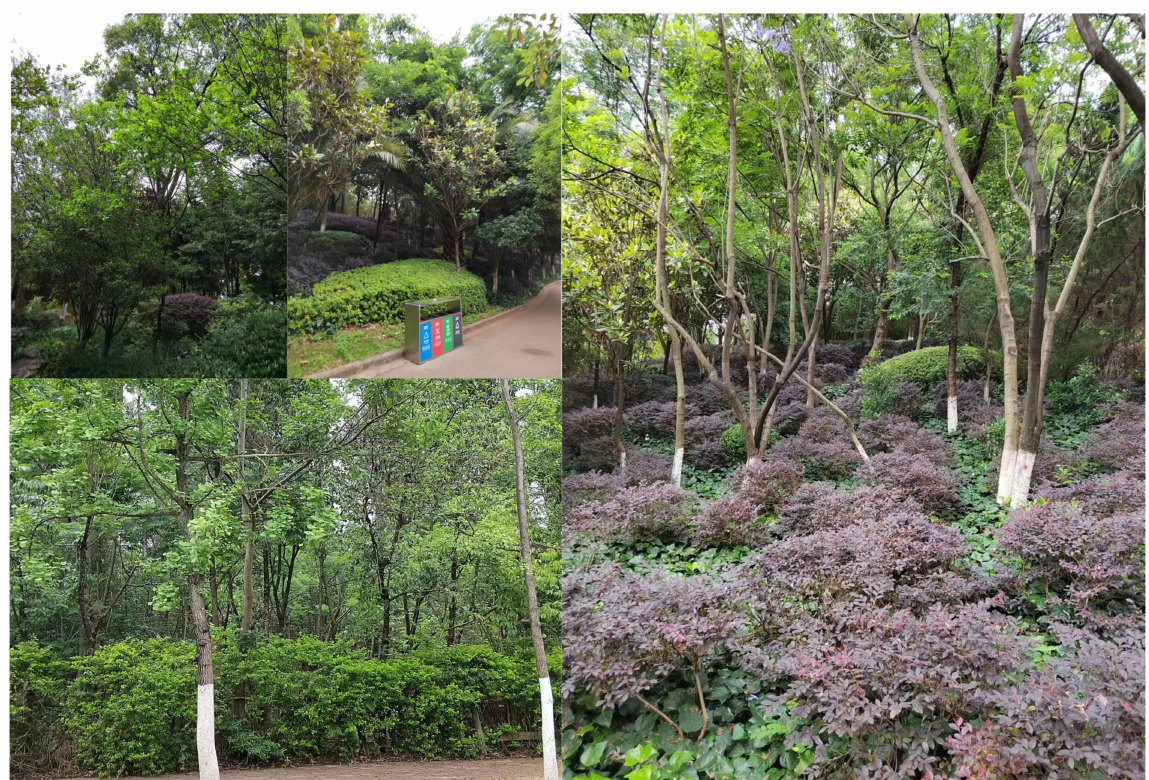
Figure 13. The areas with high vegetation